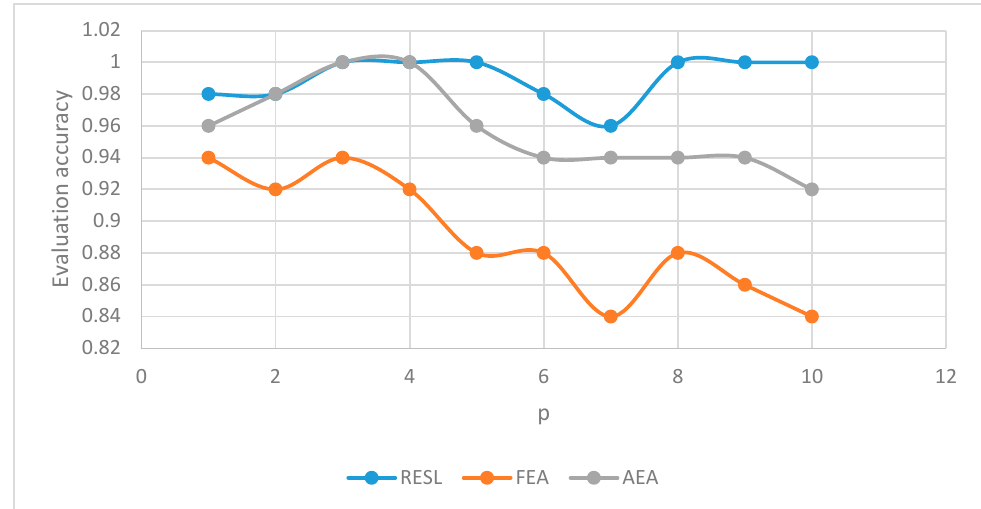
Figure 2. Evaluation accuracy.